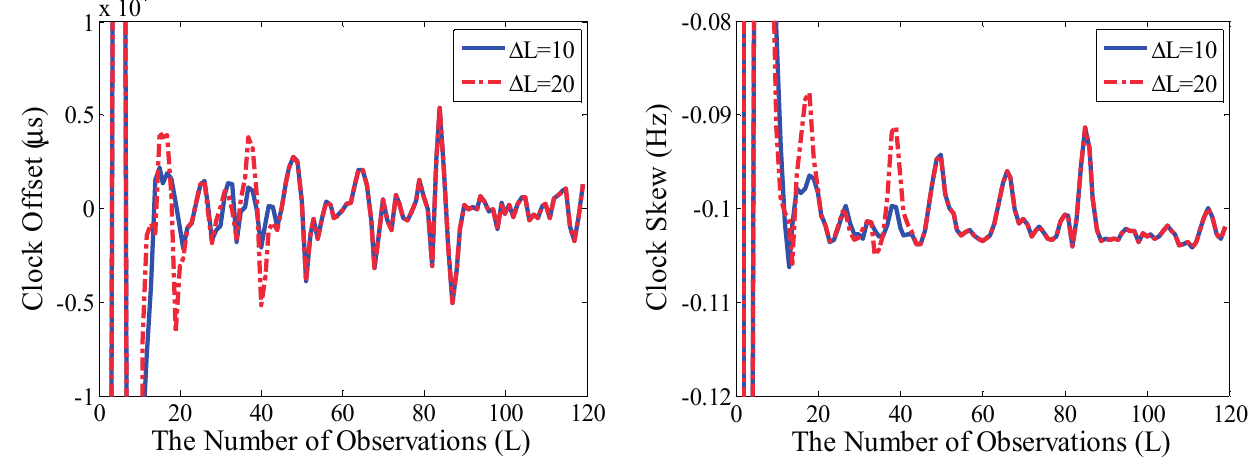
Figure 8. Tracking curves for different intervals (time interval 5